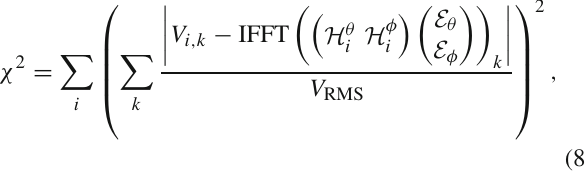
measured signal only differs in noise contribution. Upper right panels: Reconstructed amplitude spectrum using the forward folding (dashed orange) and standard (solid green) technique in comparison with the simulated truth (solid blue). Lower right panels: reconstructed electric field trace using both techniques in comparison to the simulated true values (same colors as